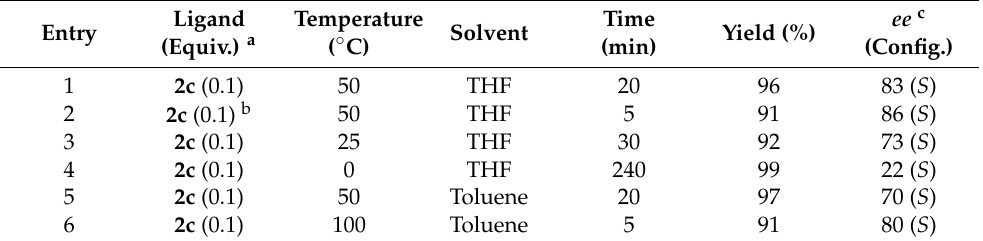
Table 2. Optimization of the reaction conditions for borane reduction of α -chloroacetophenone catalyzed by 2c